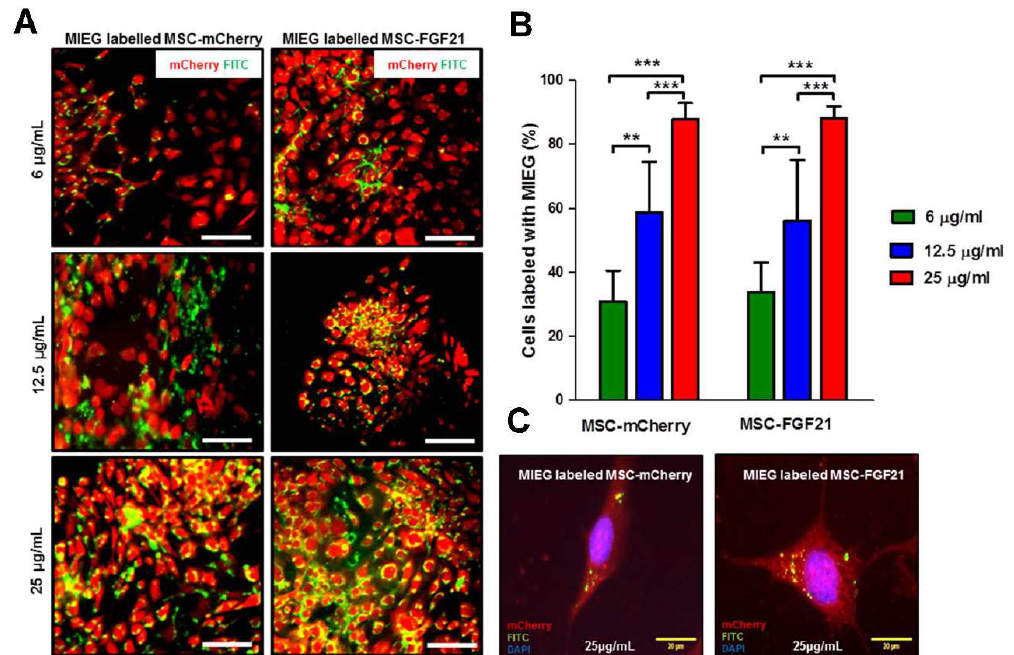
Figure 3. In vitro labeling of MSCs with MIEG. ( A ) Presence of MIEG in MSCs was detected by fluorescence microscope. Representative images fluorescence microscope of MSC-mCherry and MSC-FGF21 incubated with different concentrations of MIEG for 24 h. ( B ) Labeling percentage in monolayer cultures of MSC-FGF21 and MSC-mCherry exposed to 6, 12.5, and 25 μg/mL of MIEG for 24 h. ( C ) Representative fluorescence microscope image demonstrating the characteristic intracellular distribution of MIEG (green) in MSCs after 24 h. Data represent mean ± S.E.M. of triplicate values from three separate experiments. ** p < 0.01, *** p < 0.005. Scale bar 50 μm unless stated otherwise.